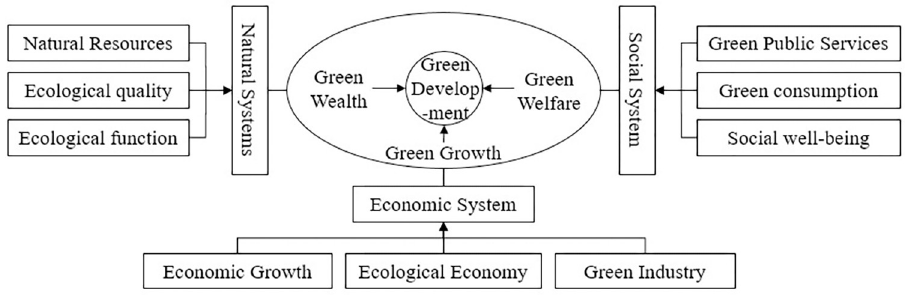
Fig 1. The theoretical framework of green development